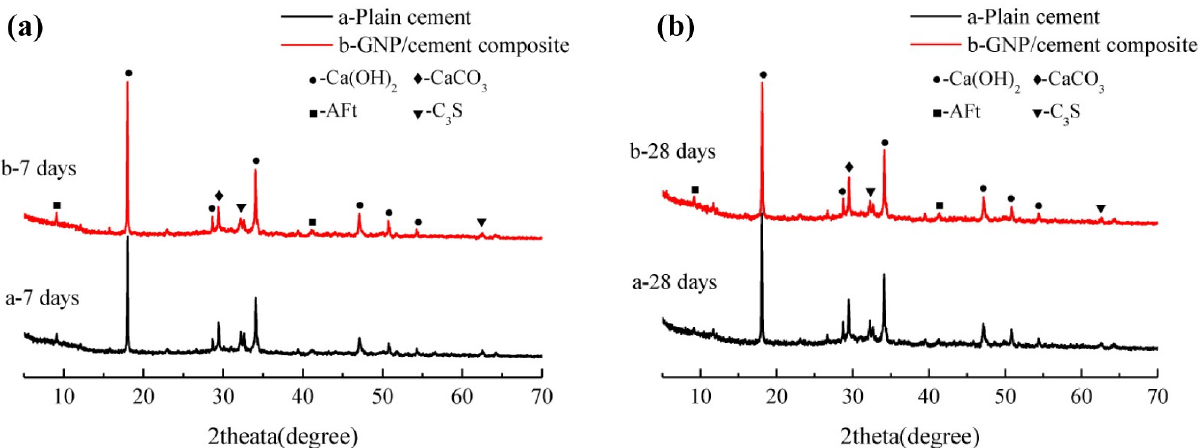
Figure 7: XRD patterns for plain and GNP-cement after (a) 7 days; (b) 28 days